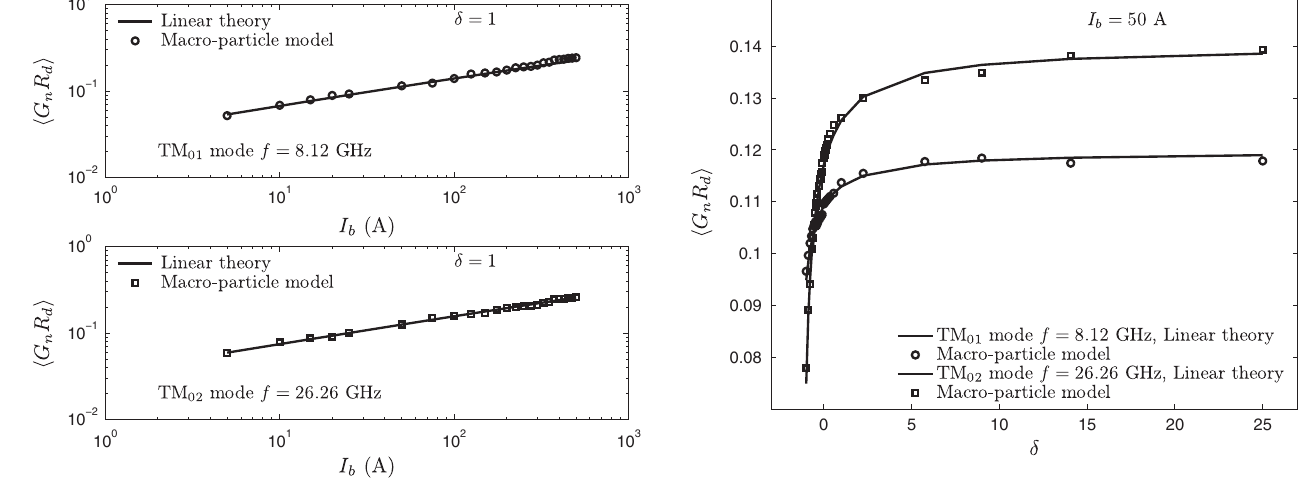
FIG. 12. Normalized growth rates for TM 01 and TM 02 modes FIG. 10. Normalized growth rates for TM 01 and TM 02 modes as a function of inhomogeneity scale factor for a 50 A beam. as a function of beam current for (cid:1) ¼ 1 . Both spatial growth . rates are proportional to I 1 = 3 b